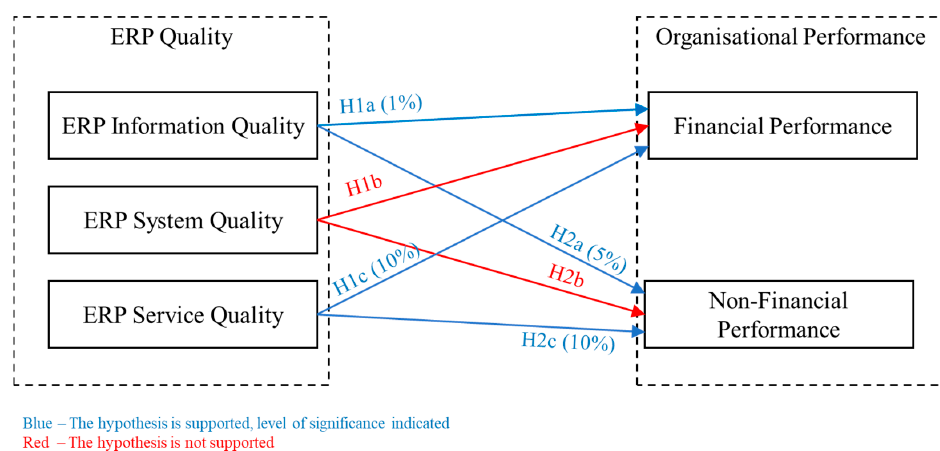
Figure 2. Path estimation results.